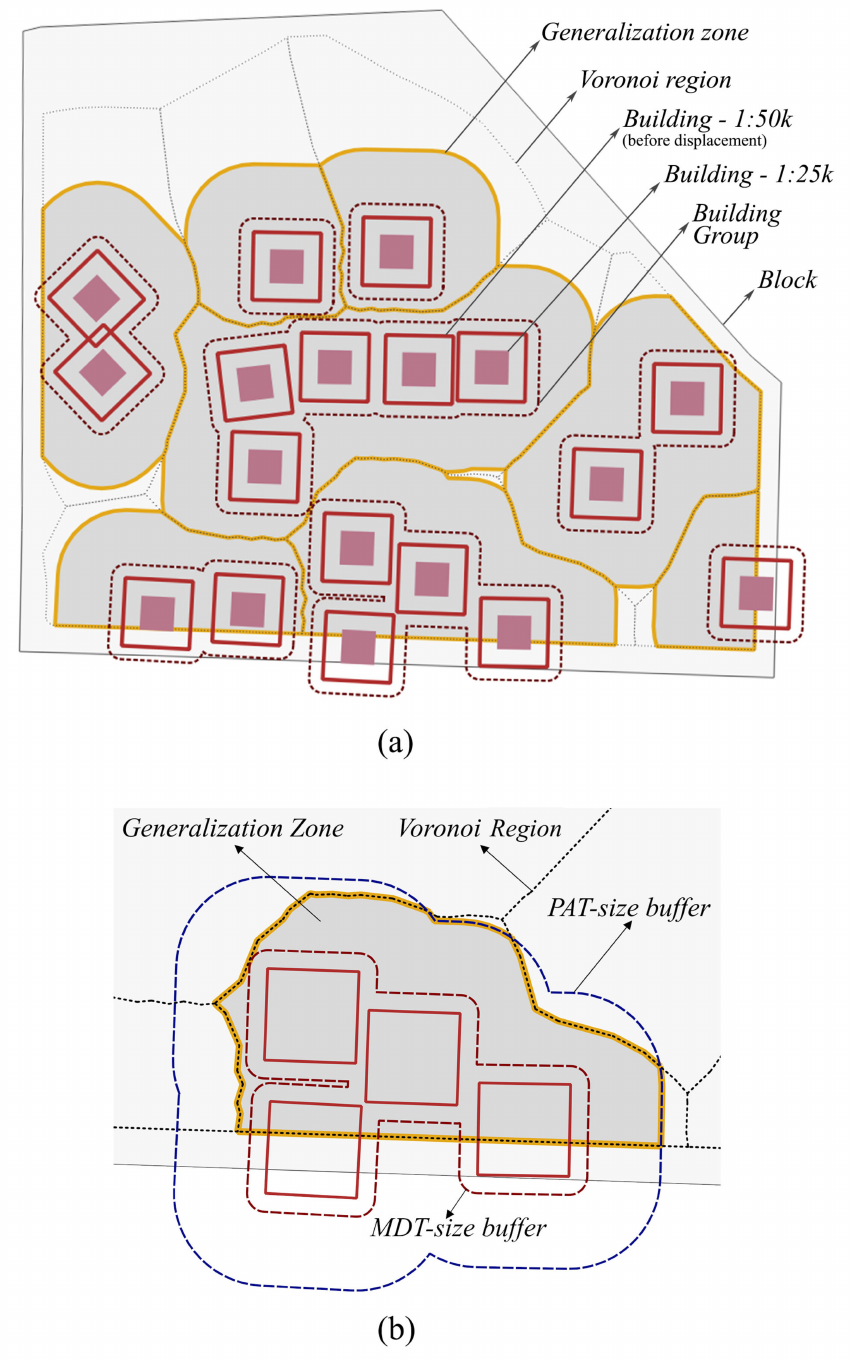
Figure 1. Map space allocation to the building groups in the blocks (adapted from [1]). ( a ) block, generalization zones and building groups, ( b ) generation of generalization